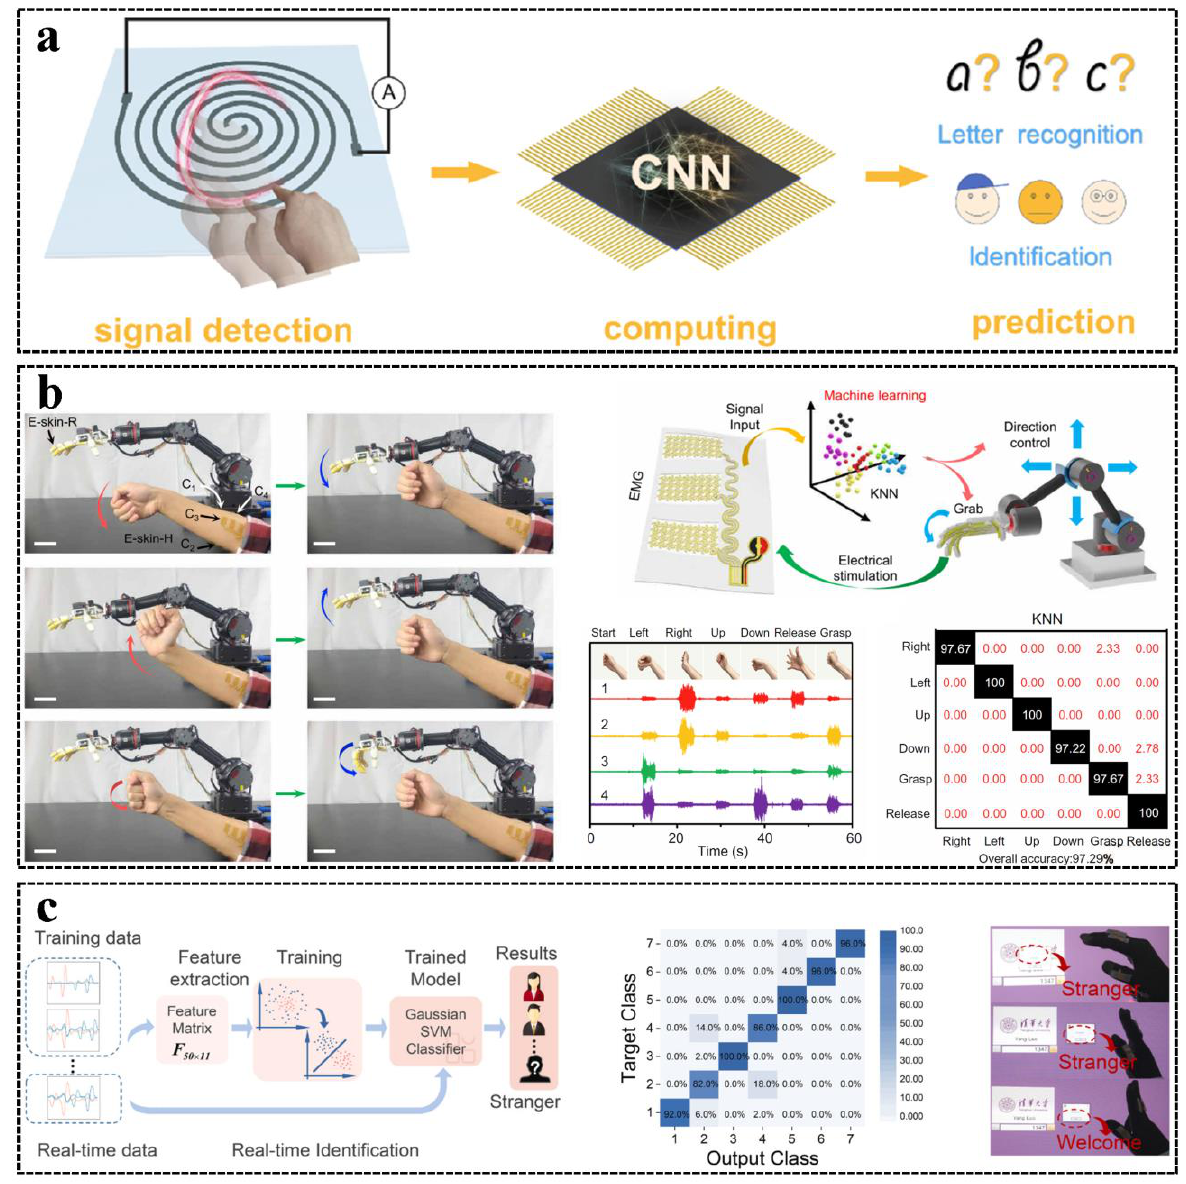
Figure 7. Machine-learning enhanced HMIs: ( a ) A handwriting input panel with 1D output using a